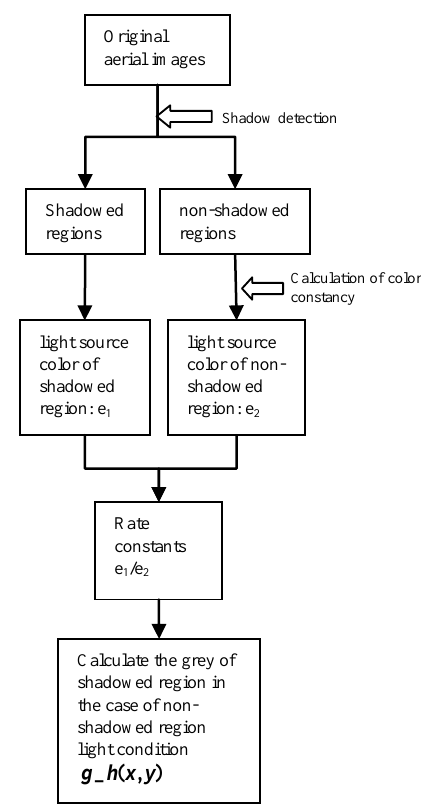
Figure 1. Shadow removal